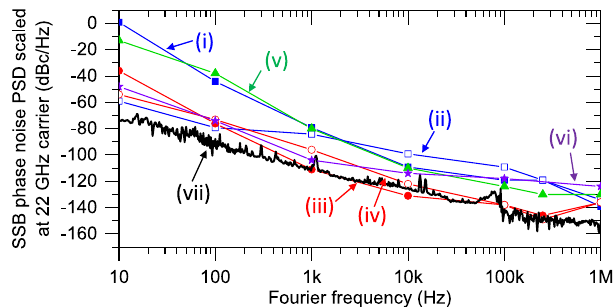
Fig. 4 Phase noise performance comparison. Phase noise comparison with other microcomb-based microwaves scaled to 22 GHz. (i) Free-running 20- GHz Si 3 N 4 microcomb 33 , (ii) Stabilised 20-GHz Si 3 N 4 microcomb 33 , (iii) Free-running 14-GHz MgF 2 microcomb 32 , (iv) Stabilised 14-GHz MgF 2 microcomb 32 , (v) Free-running 22-GHz SiO 2 microcomb 31 , (vi) Free- running 10-GHz MgF 2 microcomb 60 . (vii) Fibre-stabilised 22-GHz SiO 2 microcomb (this work). Source data for Fig. 4 are provided in the Supplementary